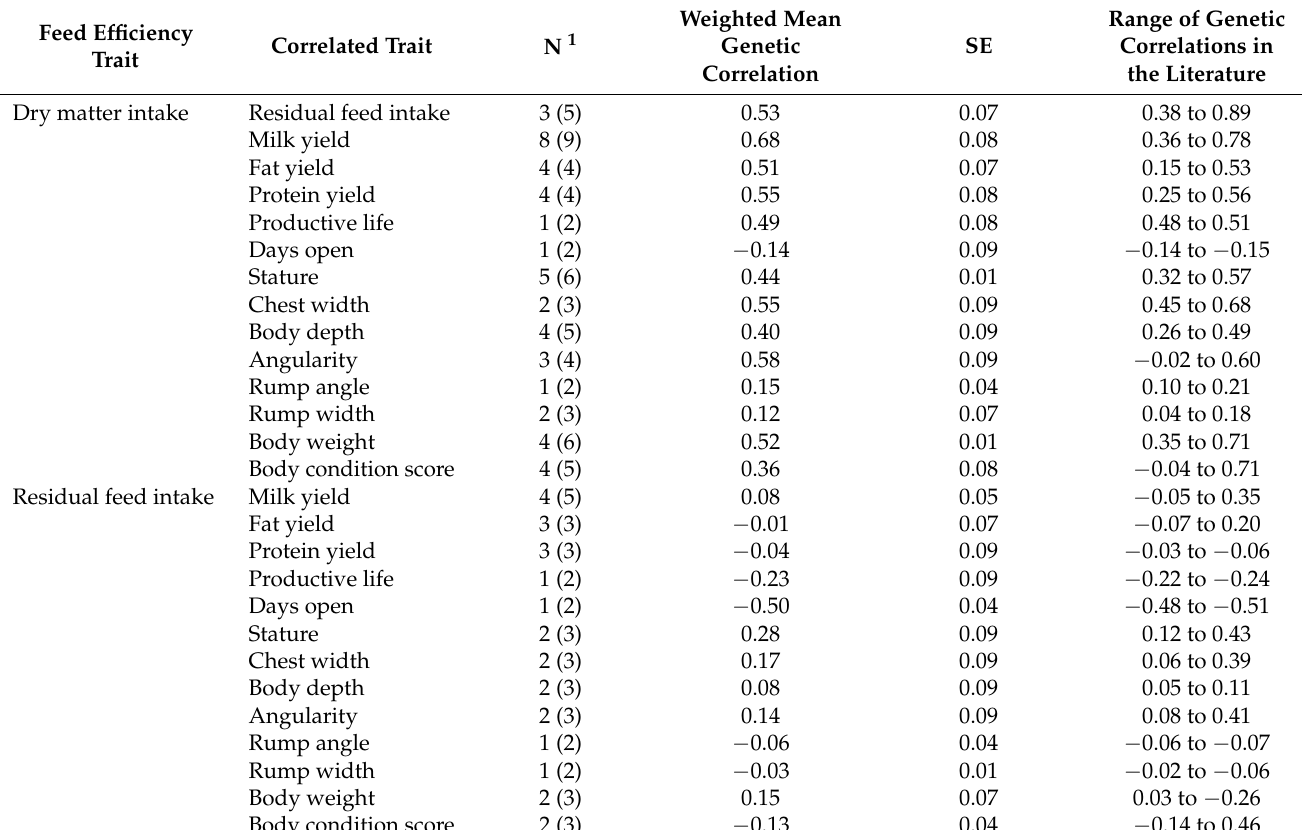
Table 2. Weighted mean genetic correlations and summary statistics between feed efficiency traits and production, reproduction, longevity, type, body weight, and body condition score traits calculated by meta-analysis for Holsteins across countries.